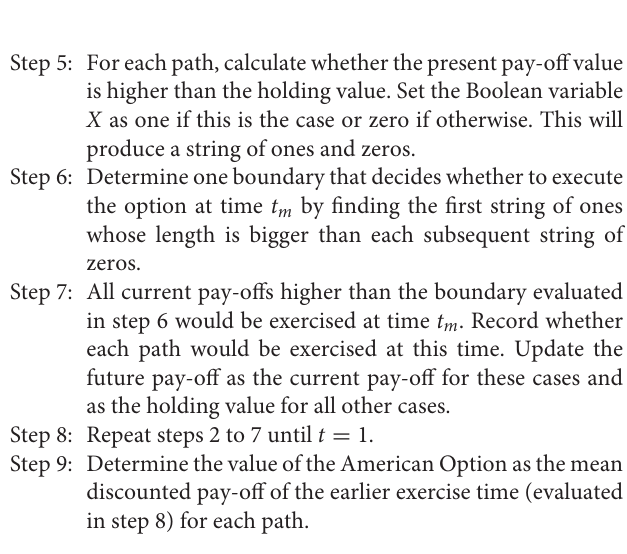
stock price paths. The steps for pricing an American stock option using this method, assuming K times during which this option can be exercised, are summarized below. A novice may wish to consult Appendices A and B as these show the steps applied for a generation of sixteen paths.